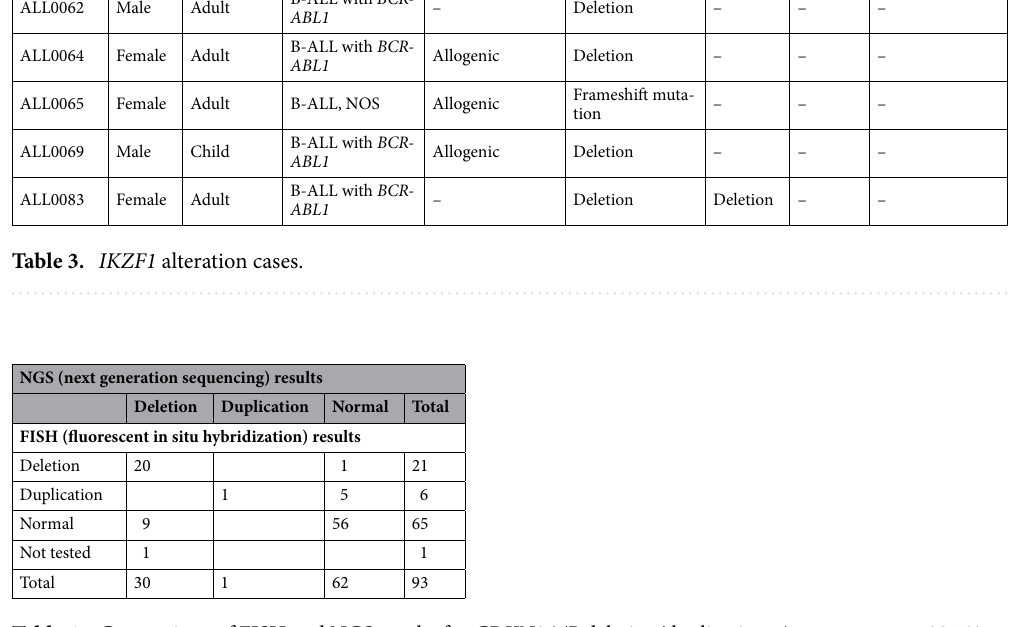
Table 4. Comparison of FISH and NGS results for CDKN2A/B deletion/duplication. Agreement rate: 83.7%.